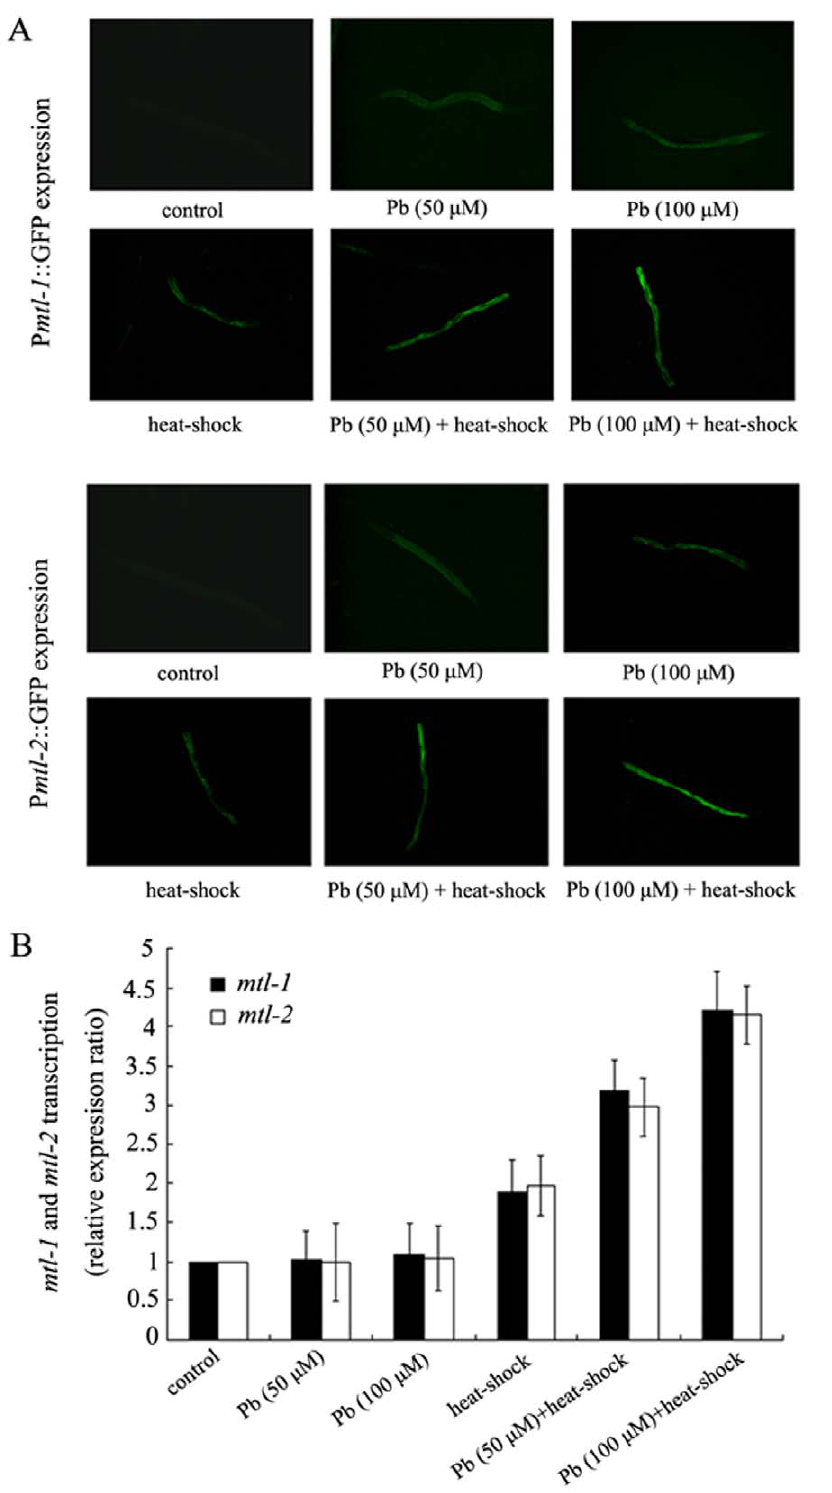
Figure 5. Induction of metallothionein gene expression during the formation of cross-adaptation response to neurobehavioral toxicity induced by Pb exposure. (A) Induction of green fluorescence protein in the P mtl-1::GFP and P mtl-2::GFP transgenic nematodes. (B) mtl-1 and mtl-2 transcription assay. Relative expression ratio (between mtl-1 or mtl-2 gene and ubq-1 reference gene) in treatments are normalized to the control. L2-stage larvae animals were heat stressed for 1 h at 36 u C. The exposed metal concentrations were 50 and 100 m M. Bars represent means 6 S.D.